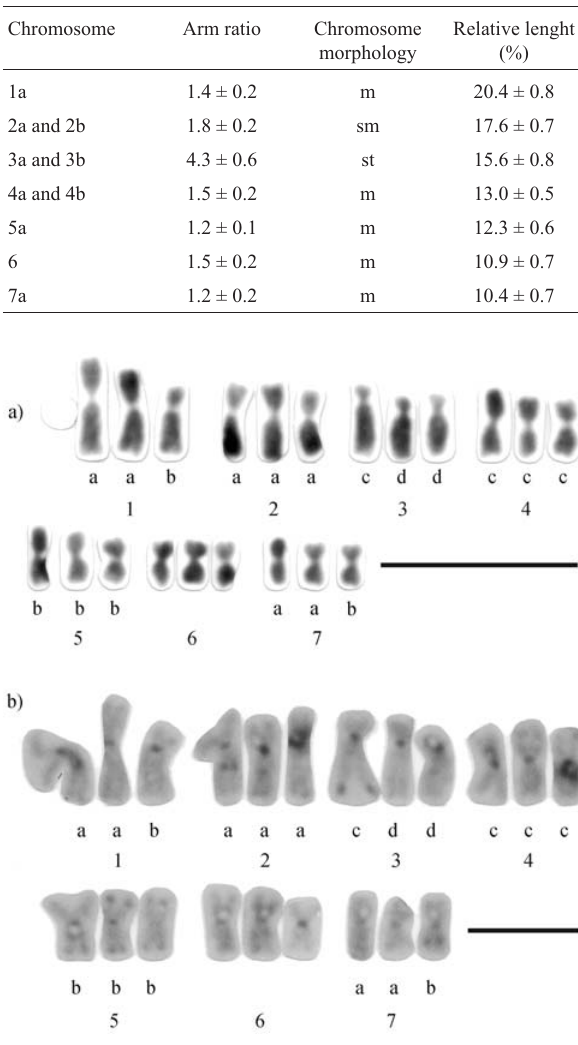
Table 2 - Karyometric data of diploid specimens of Dolichoplana carvalhoi (2n = 2x = 14 chromosomes) obtained after measurements of 13 conventionally stained mitotic